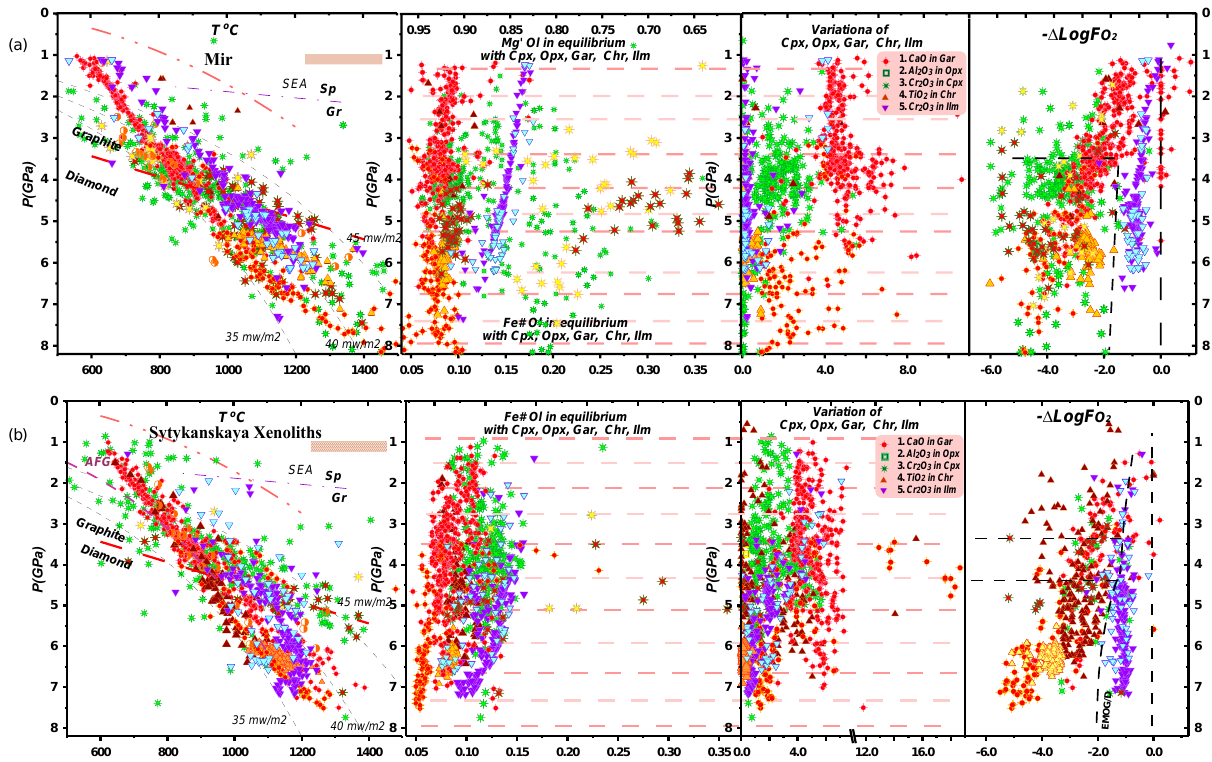
Figure 10. (a) PTXfO 2 estimates for minerals from xenocrysts and xenoliths from the Mir pipe. Symbols are the same as for Fig. 9a. (b) PT estimates for the minerals from xenocrysts and xenoliths from the Sytykanskaya pipe and variations of the Fe# for coexisting olivines vs. pressure estimates obtained with monomineral thermobarometry. Symbols are the same as for Fig. 9a.